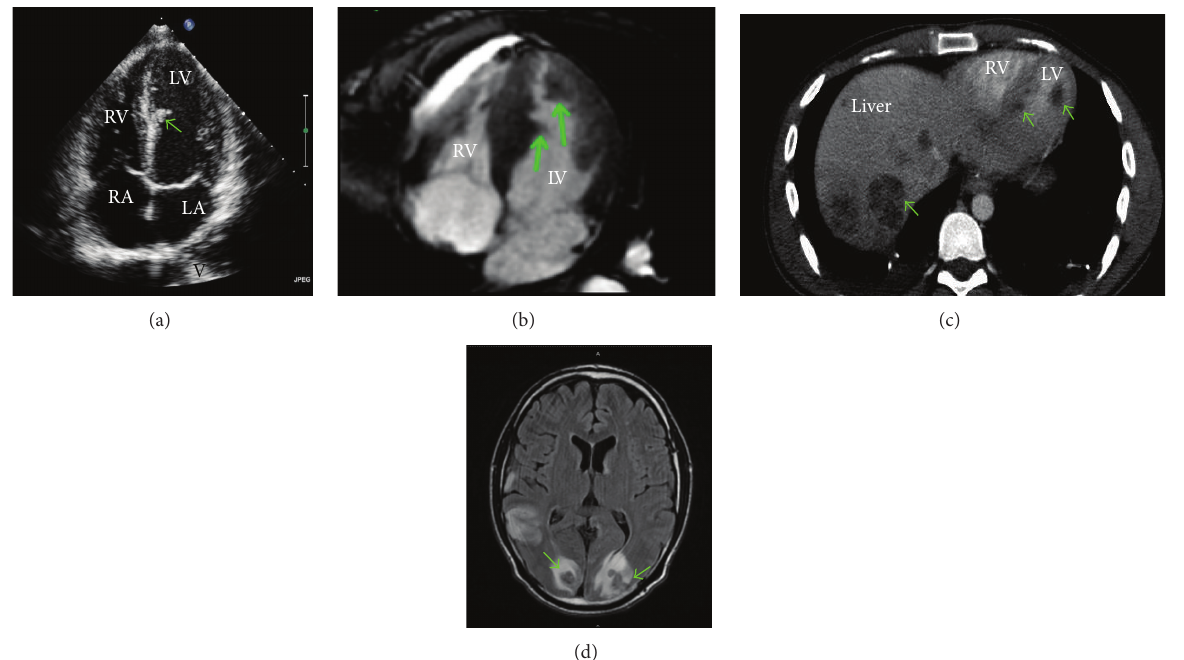
Figure 1: (a) An apical 4-chamber view of 2D echo showing mass in left ventricular cavity attached to left side of interventricular septum. (b) Cardiac MRI showing masses in left ventricular cavity attached to the interventricular septum and lateral wall. (c) CT chest and abdomen showing left ventricular masses and metastatic liver lesions. (d) MRI brain showing bilateral occipital lobe metastatic lesions surrounded by vasogenic